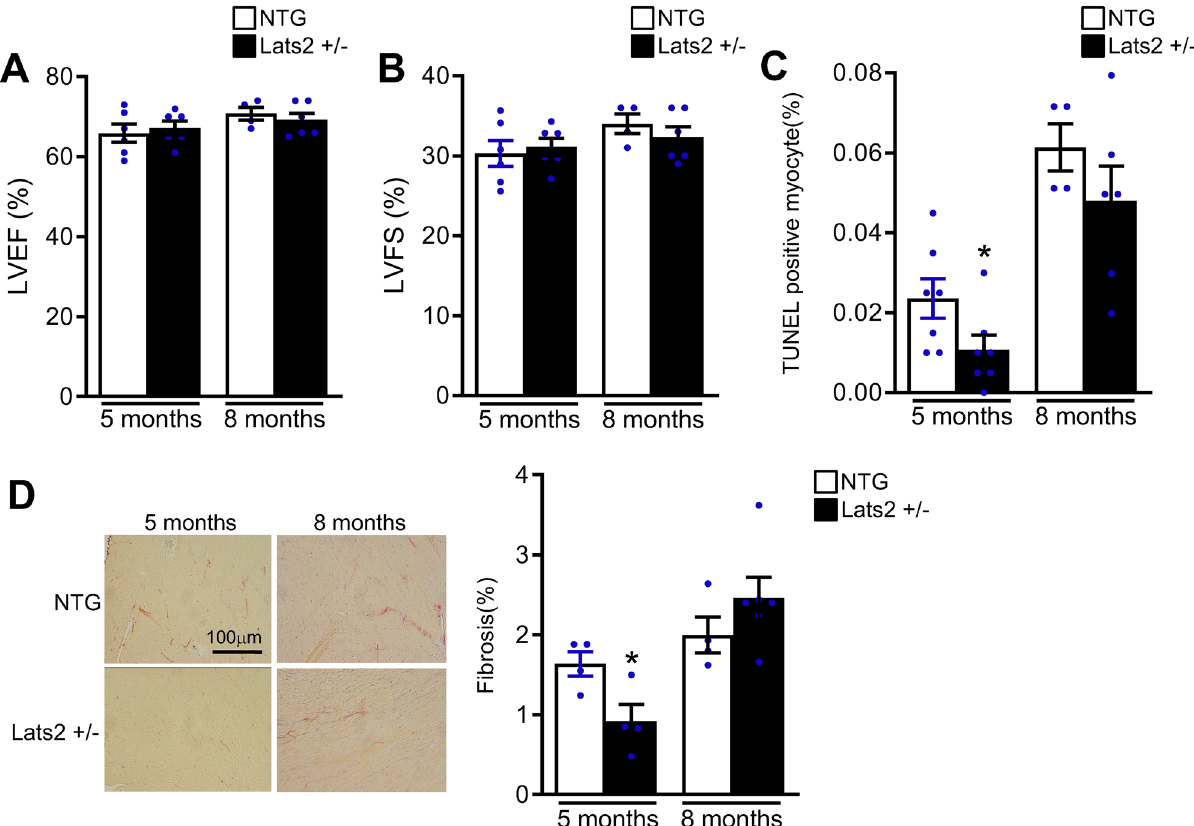
Figure 1. Baseline phenotype of Lats2 +/- mouse hearts. Non-transgenic (NTG) and Lats2 +/- mice were euthanized at 5 or 8 months of age. ( A ) and ( B ), Left ventricular ejection fraction (LVEF) ( A ) and left ventricular fractional shortening (LVFS) ( B ) were evaluated with echocardiographic analyses. ( C ), Myocardial apoptosis was evaluated with TUNEL assays. ( D ), Myocardial fibrosis was evaluated with Picrosirius Red staining. * p < 0.05 versus sham